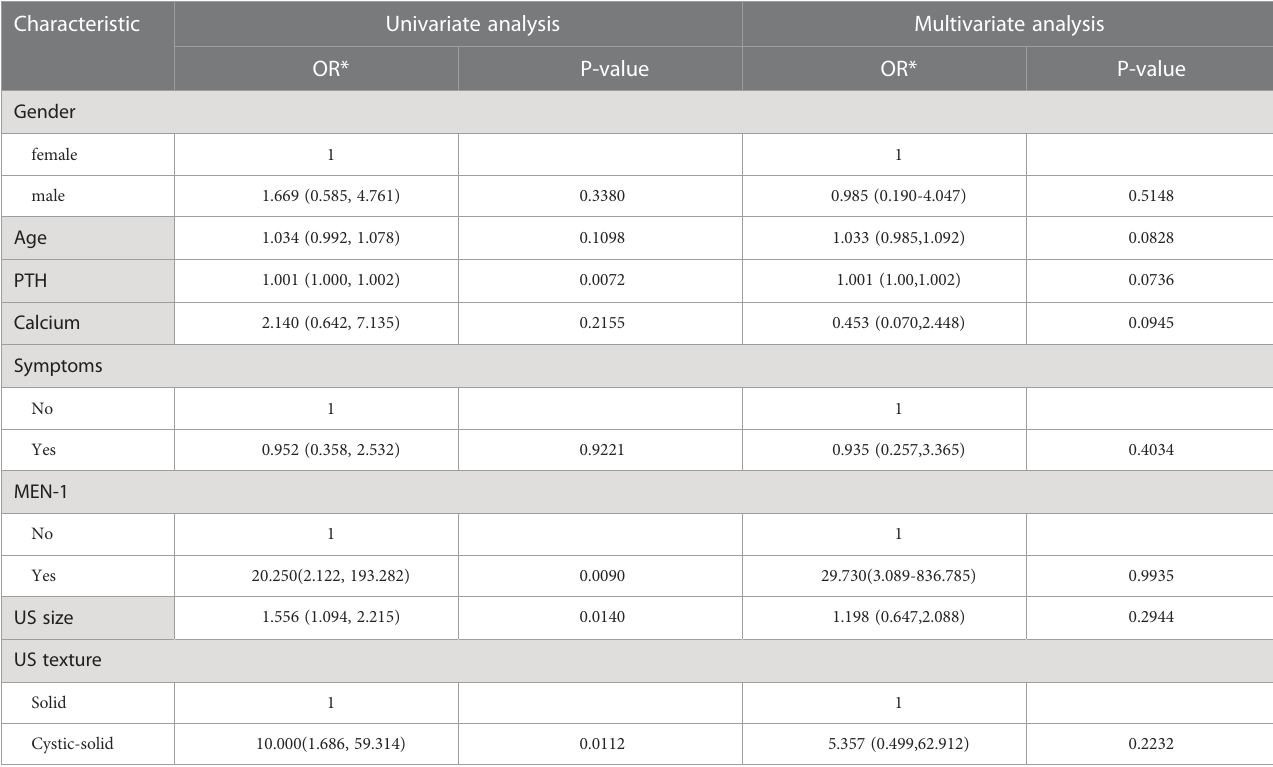
TABLE 2 Univariate and multivariate logistic regression analysis of factors associated with